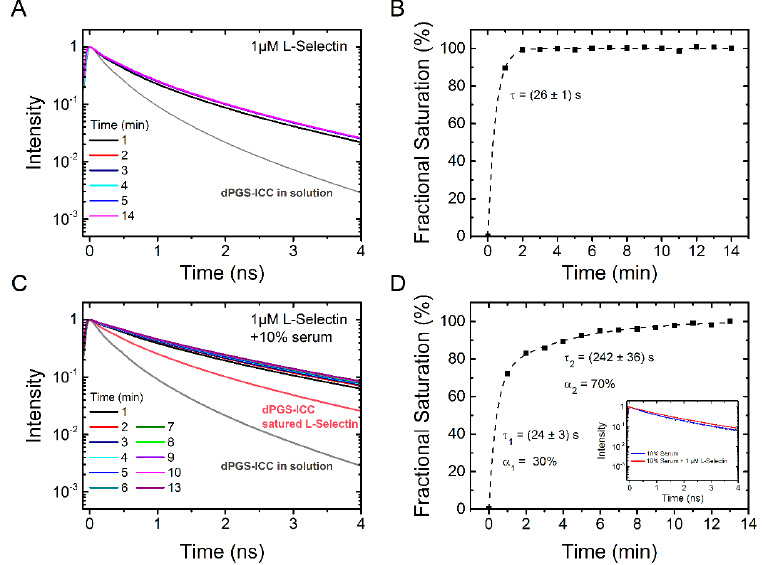
Figure 9. Time dependence of dPGS-ICC binding to L-selectin and effect of serum. ( A ) Lifetime decay curves of 0.1 µM dPGS-ICC binding to 1 µM L-selectin and ( B ) the fractional saturation, based on the mean fluorescence lifetimes, as a function of time. The value of τ = 26 s was obtained from an exponential fit to the data (dashed line); ( C ) Lifetime decay curves of 0.1 µM dPGS-ICC binding to 1 µM L-selectin upon addition of human serum (final concentration: 10% serum) and ( D ) the fractional saturation, based on the mean fluorescence lifetimes, as a function of time. A bi-exponential fit to the data (dashed line) yielded two time constants of τ 1 = 24 s and τ 2 = 242 s with amplitudes of 30% and 70% respectively. Inset: fluorescence lifetime curves of dPGS-ICC in 10% serum and in 10% serum with 1 µM L-selectin. Table 1. Fluorescence lifetime parameters for different dPGS-ICC interaction partners according to Equation (1). The mean fluorescence lifetime (Equation (2)) and the reduced Χ 2 is given.